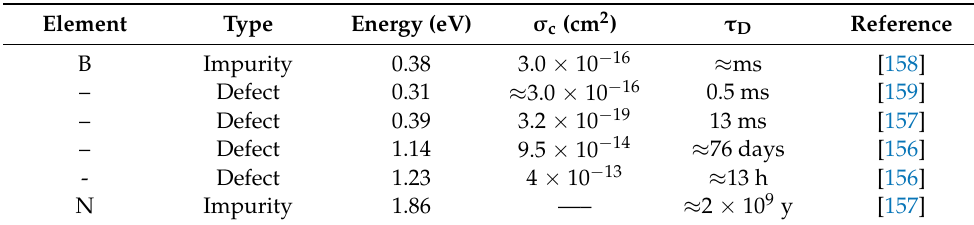
Table 3. Parameters of the deep level traps in SCD diamond. The reported data are taken from the references listed in Column